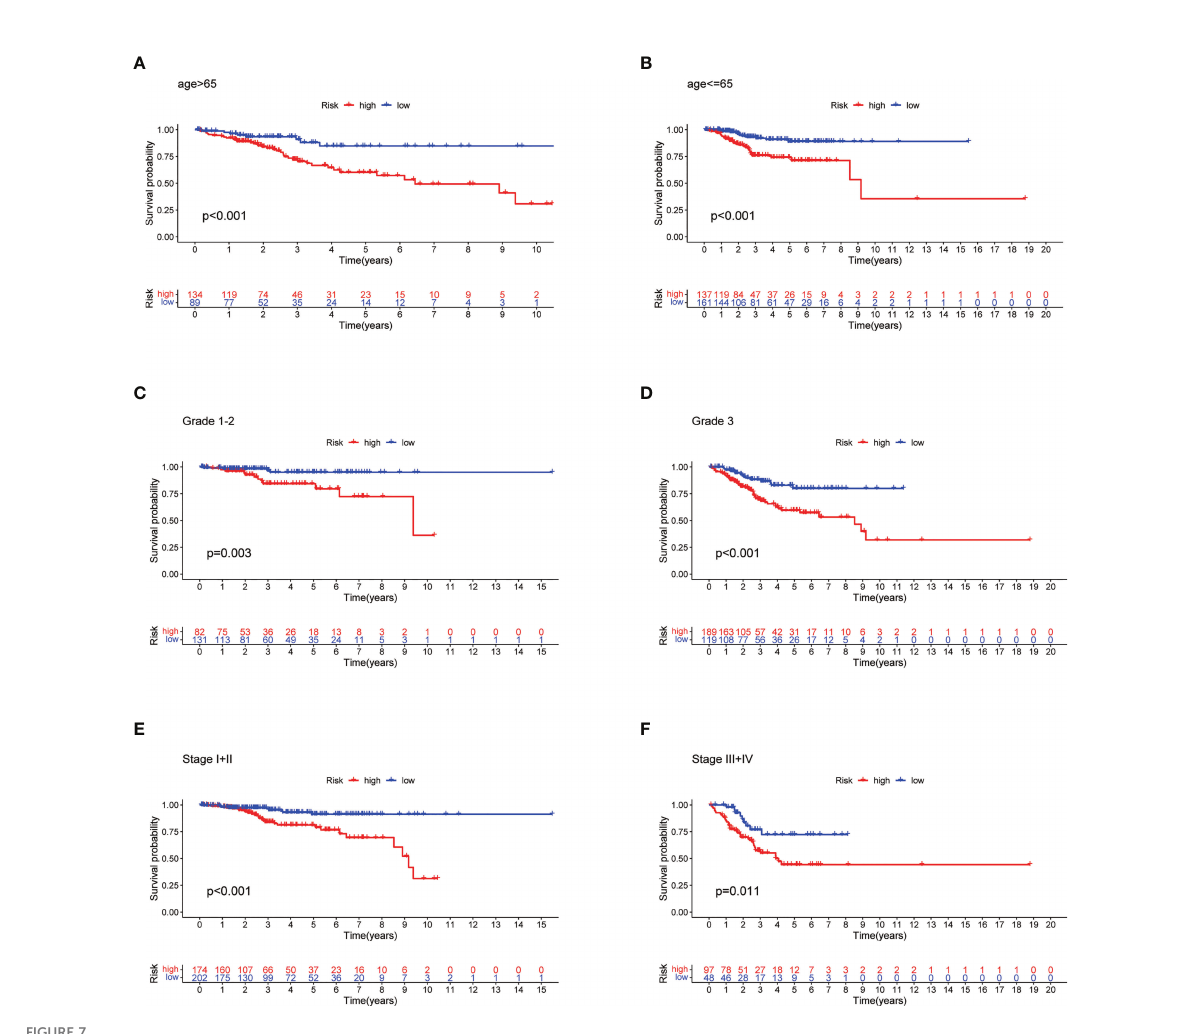
FIGURE 7 Strati fi ed Prognostic Analysis. Kaplan-Meier survival curves of OS for patients in the low- and high-risk groups strati fi ed by different clinicopathological variables. (A) Patients with age >65. (B) Patients with age ≤ 65. (C) Patients with grades 1-2. (D) Patients with grade 3. (E) Patients with stages I-II. (F) Patients with stages III-IV.